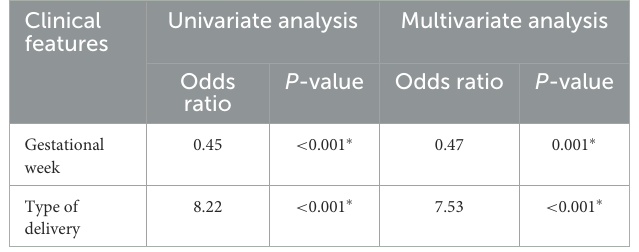
TABLE 2 Univariate and multivariate logistic regression analysis of clinical features in the training